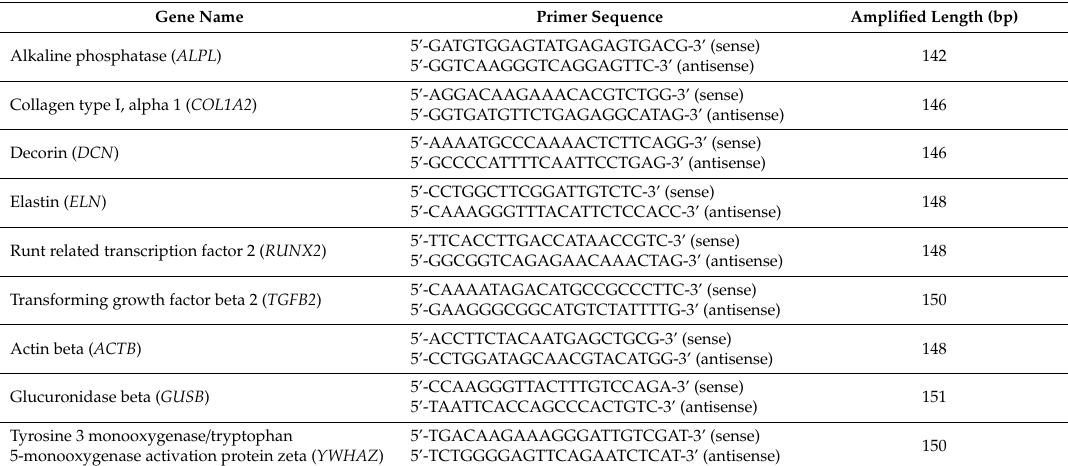
Table 1. Primer sequences for SYBR Green real-time